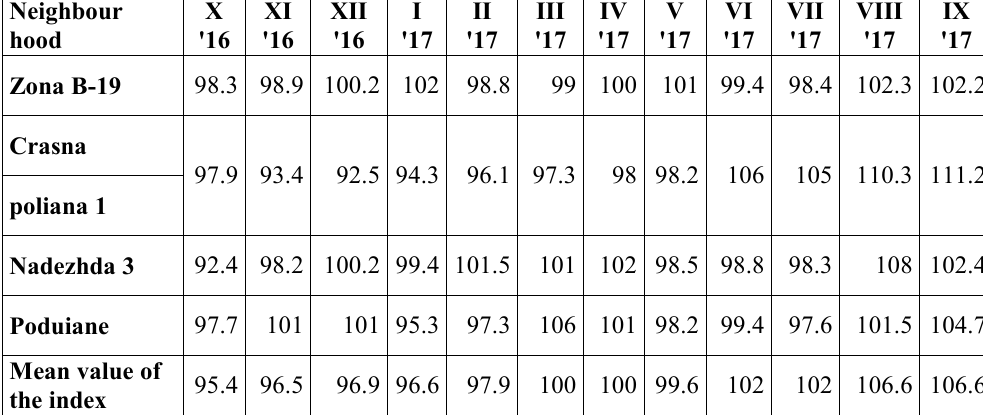
Table 3. Indices for seasonality in the change of the offered prices for sale of two- bedroom flats in some neighbourhoods of Sofia for the period October 2016 – September